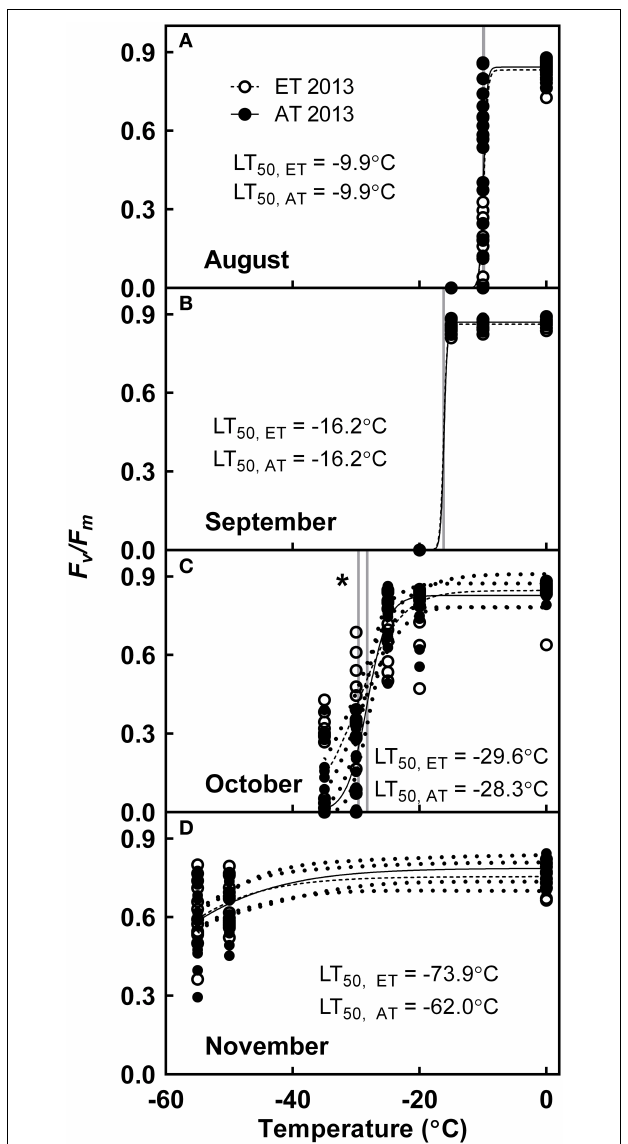
FIGURE 9 | Effect of elevated temperature on cold hardening in field-grown white pine seedlings during autumn. Freezing tolerance was assessed in (A) August; (B) September; (C) October; and (D) November of 2013. Dotted lines, where present, indicate 95% confidence interval (CI) of model. AT and ET, seedlings grown at ambient and elevated temperature, respectively. Solid line indicates ambient temperature model; dashed line indicates elevated temperature model. Gray lines indicate LT 50 . Asterisk indicates significant treatment effect at LT 50 ( ∗ P < 0 . 05